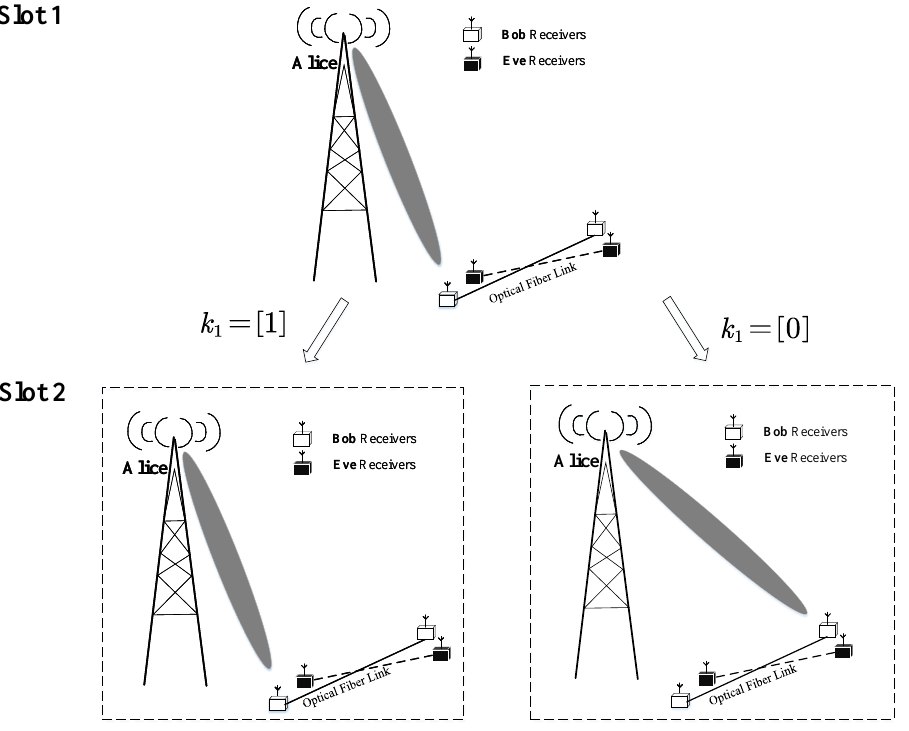
Figure 3. An example with N r = 2 for the traditional SDM activated